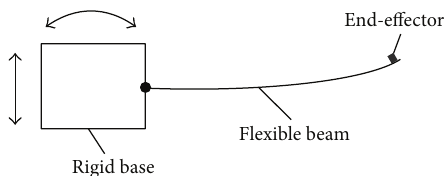
Figure 1: Schematic diagram of a flexible